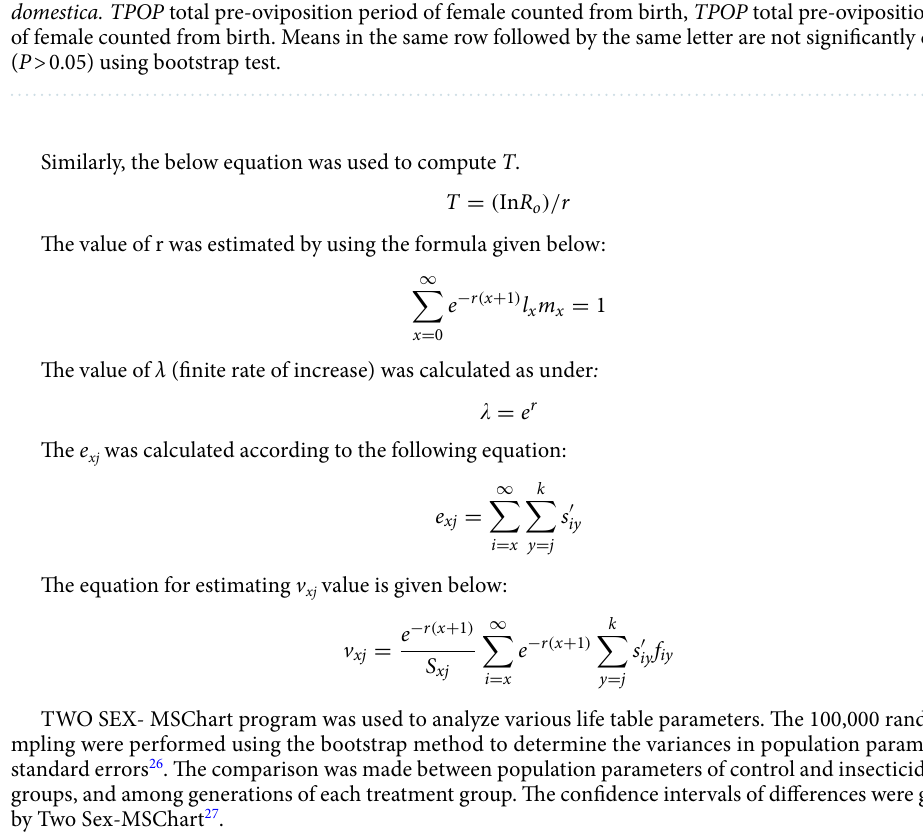
Life table parameters. Life table parameters, i.e., oviposition, male longevity, APOP, TPOP, and fecundity are given in Table 2. Data from the control group and experimental groups were used to compare the parameters (under three different concentrations, i.e., LC 10 , LC 30 , and LC 50 ). Pre-adult duration in F 1 individuals treated with lambda-cyhalothrin was significantly reduced from 13.85 d (LC 50 ) to 12.26 d (LC 10 ), while the value for the pre-adult duration in control 13.12 d was lower than LC 30 and LC 50 ( P < 0.0001). Female longevity of F 1 was significantly higher in control (27.09 d), followed by LC 10 (22.50 d), while significantly lower value (21.61 d) was noted for LC 30 .